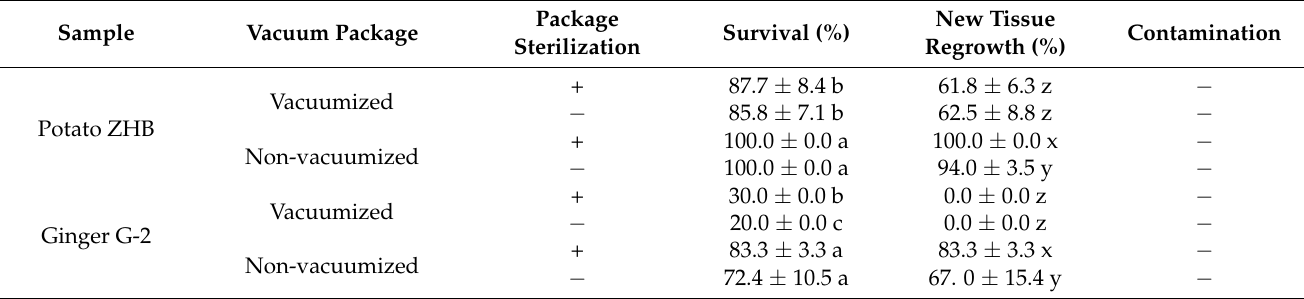
Table 1. The effect of package types on plant survival, new tissue regrowth, and medium contamination.